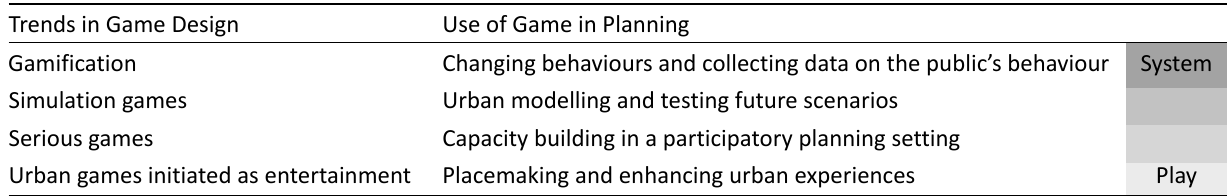
Table 3. Trends in game design and their use in planning. Trends in Game